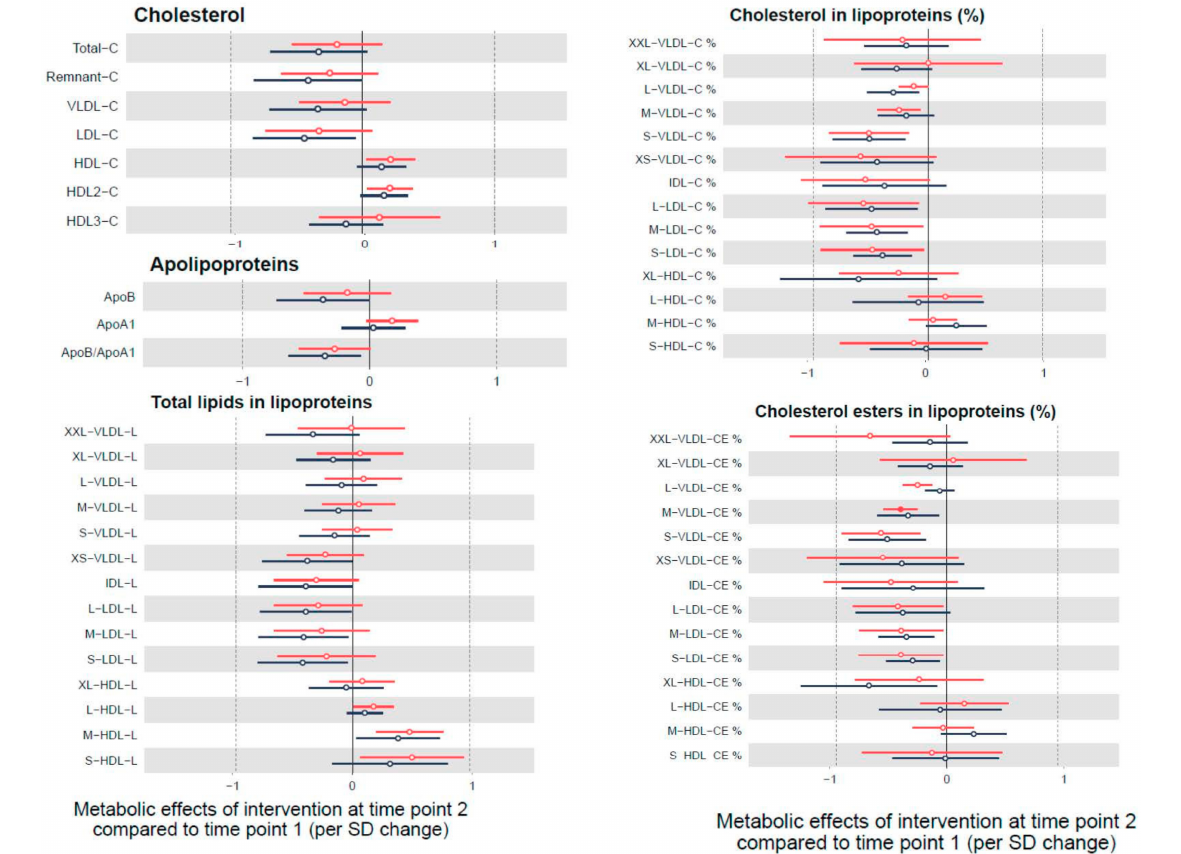
Figure 2. Metabolic e ff ects of the intervention after 6 months follow up (time point 2) compared to baseline (time point 1) (linear mixed models adjusted by age and sex). Results show changes by SD in each metabolite per unit change in mMDS score and are displayed by hollow points. Only those significant results (after correction of multiple testing) are indicated by filled points along with their 95% confidence intervals. In black is shown Group 1 (the intervention group for 12 months) that continued under a self-sustained continuation phase for another 6 months. In red is shown Group 2 (control) that received the active Mediterranean Diet Nutritional Intervention for 6